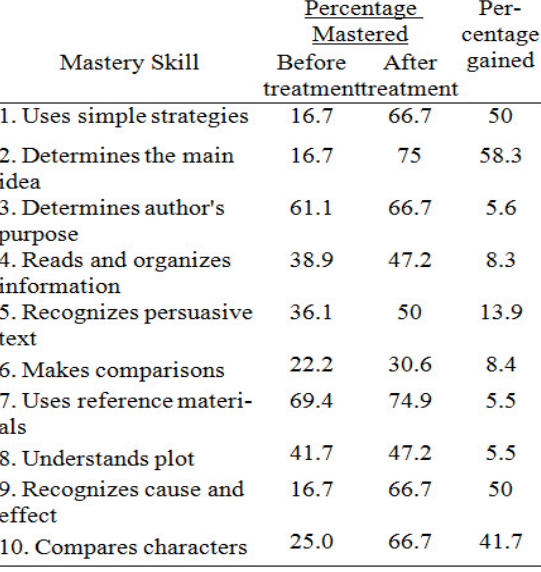
Table 1. The percentage of students